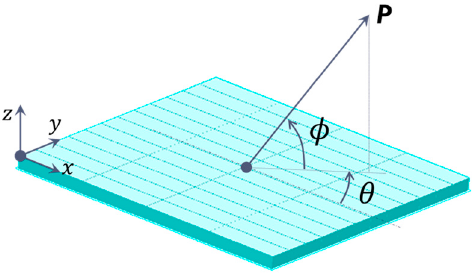
Figure 5. Definition of the cargo lashing in-plane angle θ and out-of-plane angle φ .